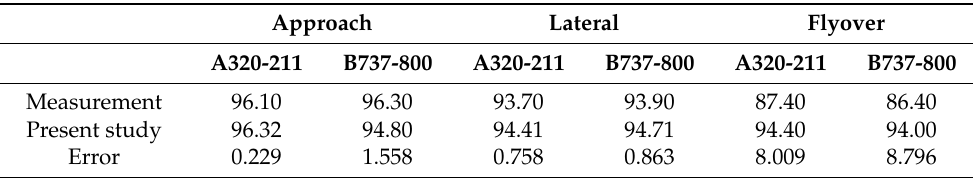
Table 2. Noise levels for B737-800 and A320-211 aircraft at three certification points, as measured and calculated (in EPNdB) with associated errors (in